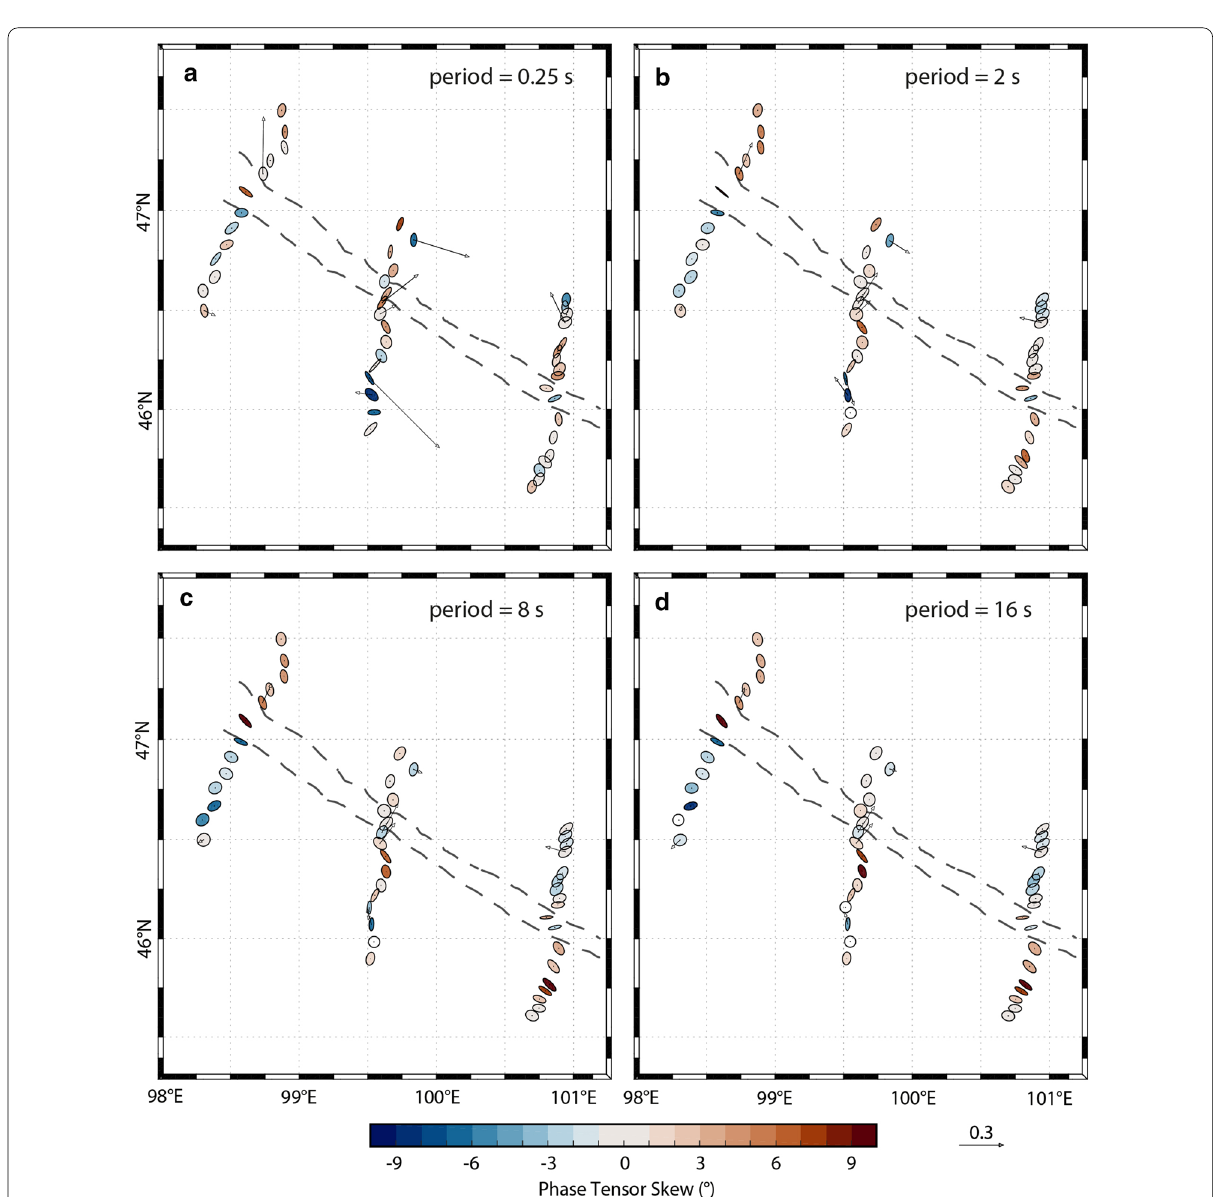
Fig. 6 Phase tensor ellipses computed from the models. They are shown in map view for selected periods of approximately a 0.25 s, b 2 s, c 8 s, and d 16 s. They have been normalized by their maximum axis values and are colored with their skew values. Induction vectors (arrows) are computed from the tipper data; they point away from conductors (i.e., Wiese convention). A scale arrow of magnitude 0.3 is shown. The approximate location of the Bayankhongor Ophiolite Belt is marked (dashed lines, as in Fig. 1). The modeled phase tensors show ellipse shapes and orientations as well as skew magnitudes and signs that are very similar to the phase tensors from the data (see Fig. 3). This indicates that the models fit the